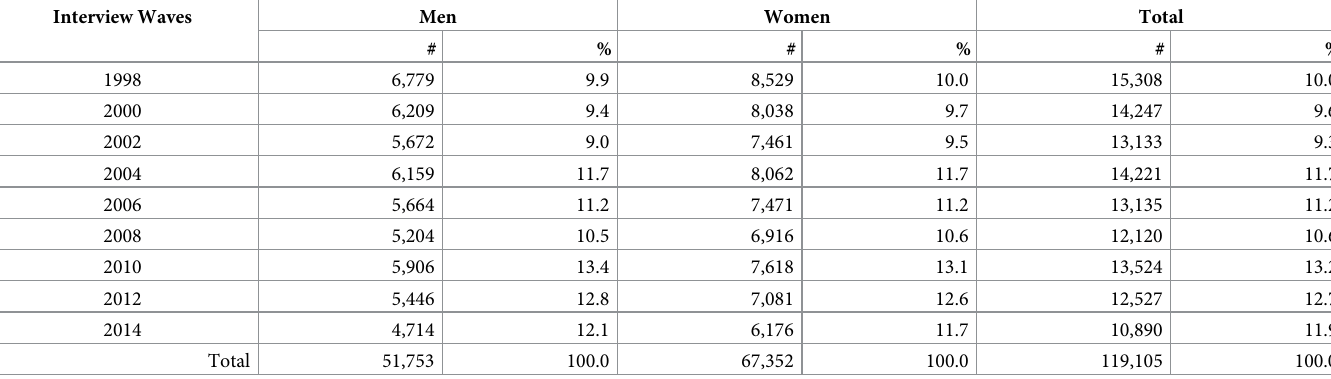
9,733 have a high school degree or above. There are 10,120 non-Hispanic whites (4,127 men and 5,993 women) who change their living arrangements during the analysis period. Table 1 displays the numbers of interview records of time-varying living arrangements by gender for non-Hispanic whites. Among interview records of non-Hispanic white men, the most common living arrangement is married/cohabiters living only with their spouses/part- ners (30,191, 51.8%); followed by married/cohabiters living with their spouses/partners and children and/or others (9,566, 22.7%) and single men living alone (7,578, 16.6%); the least common is living in a nursing home (715, 1.0%). For non-Hispanic white women, the most common living arrangement is also married/cohabiters living only with their spouses/partners (29,146, 41.1%); followed by single women living alone (19,420, 28.9%) and married/cohabi- ters living with their spouses/partners and children and/or others (7,752, 14.2%); the least common is living in a nursing home (1,936, 2.2%). Table 2 shows the numbers of interview records by gender for non-Hispanic whites across waves. Among the total 119,105 interview records, about 9% - 13% of interview records appear in each wave for men, women, and both men and women combined. Table 3 compares vital statistics and estimated results by gender for Americans at age 50. The estimated total life expectancies are 29.02, and 32.86 years for non-Hispanic white men and women respectively, while life expectancies from vital statistics at age 50 for non-Hispanic white men and women are 28.96, and 32.63 years respectively. The differences between vital Table 2. The numbers of interview records by gender for non-Hispanic whites across waves. Interview